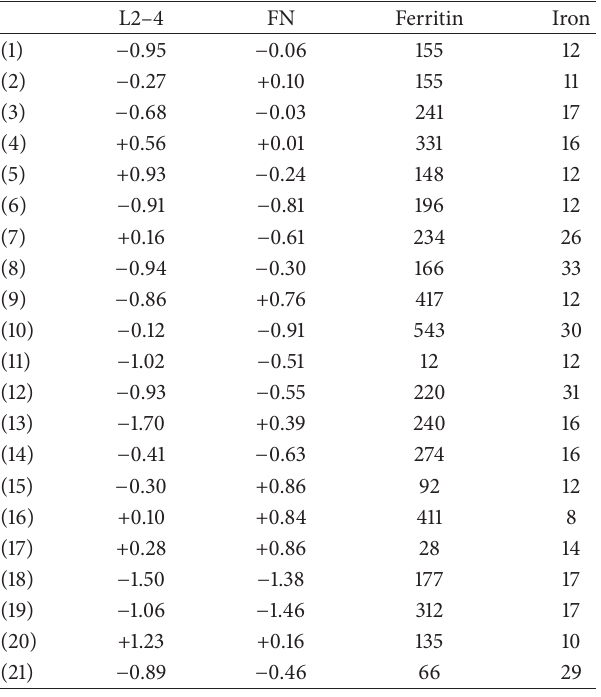
Table 1: Postmenopausal women heterozygous for the C282Y HFE mutation bone mineral density 𝑧 scores and serum ferritin and serum iron.